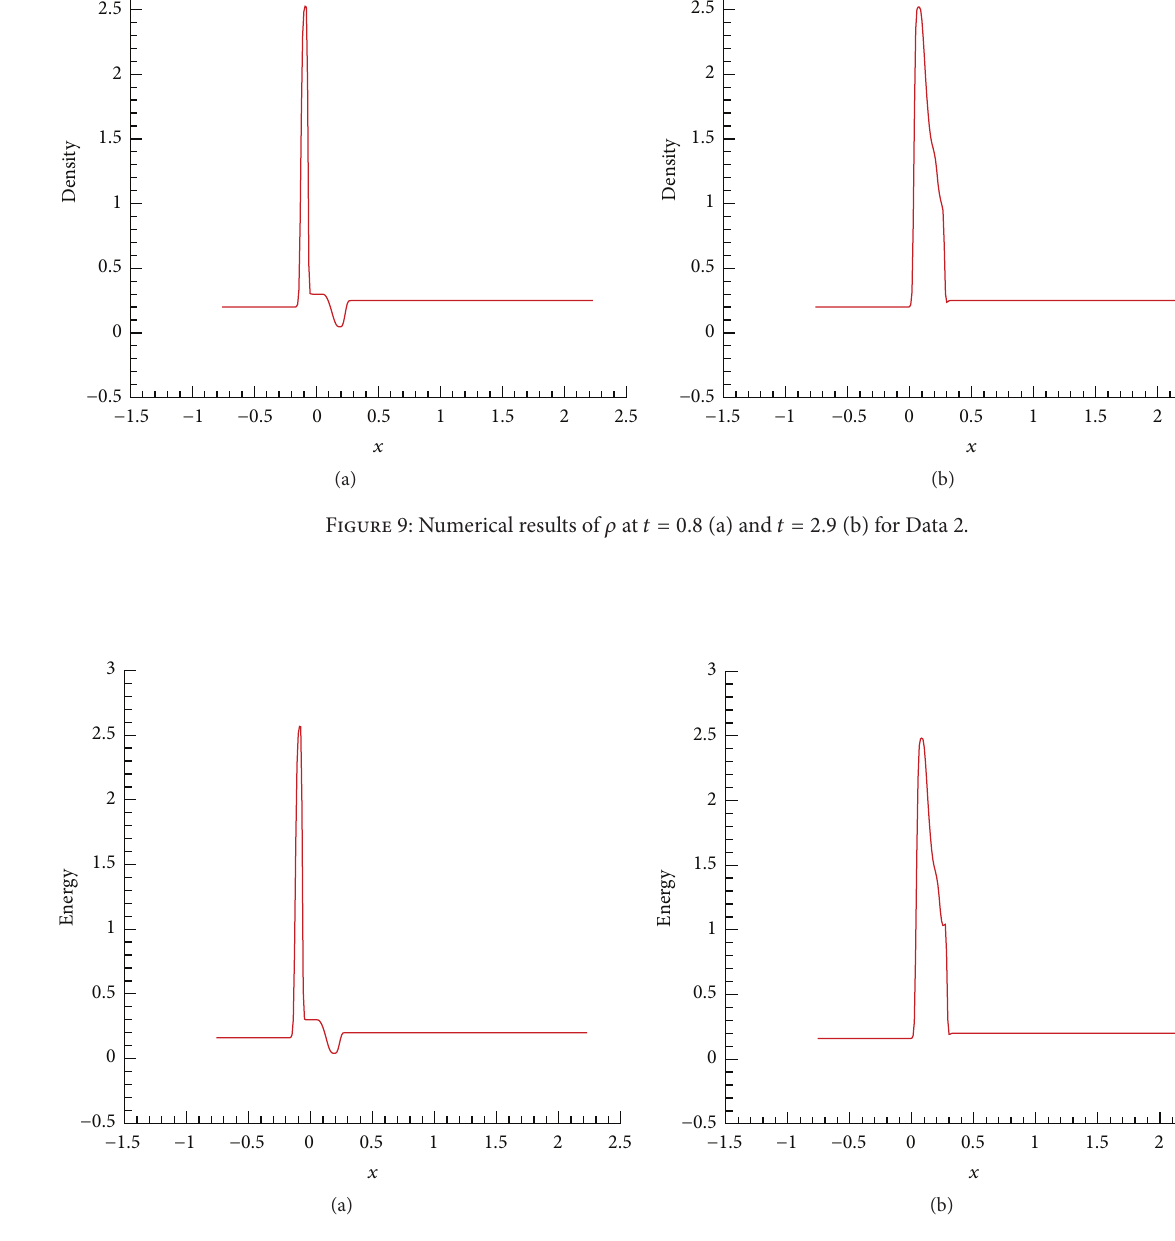
Figure 10: Numerical results of 𝐻 at 𝑡 = 0.8 (a) and 𝑡 = 2.9 (b) for Data